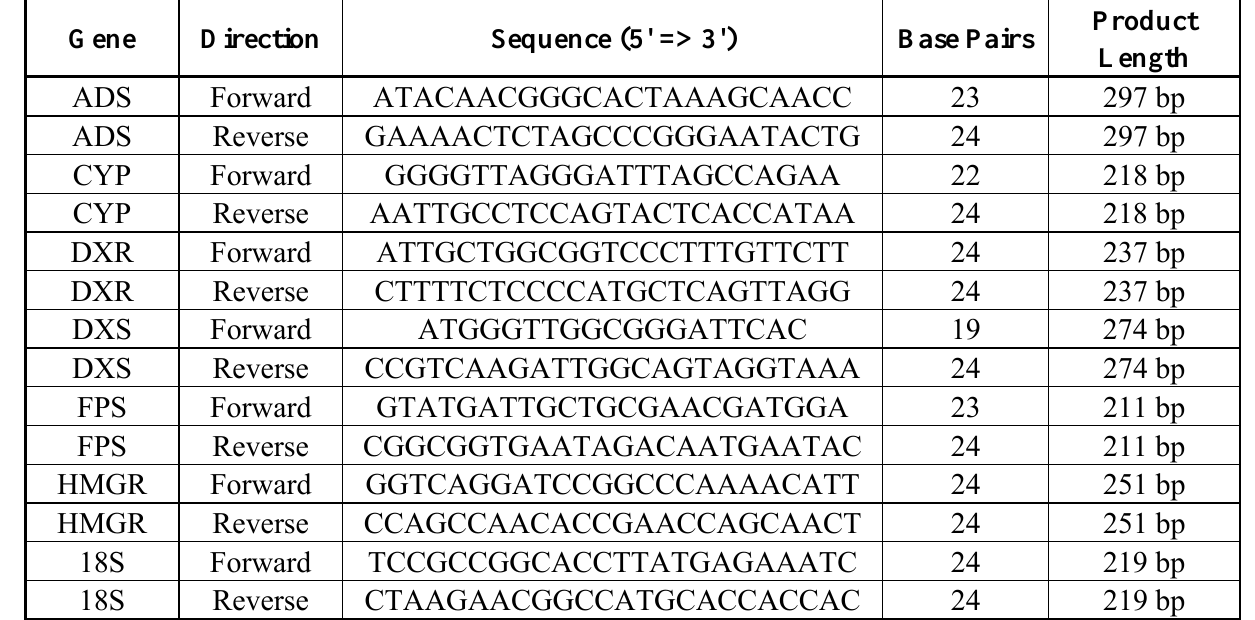
Table 1. Primer sequences for target gene amplification by